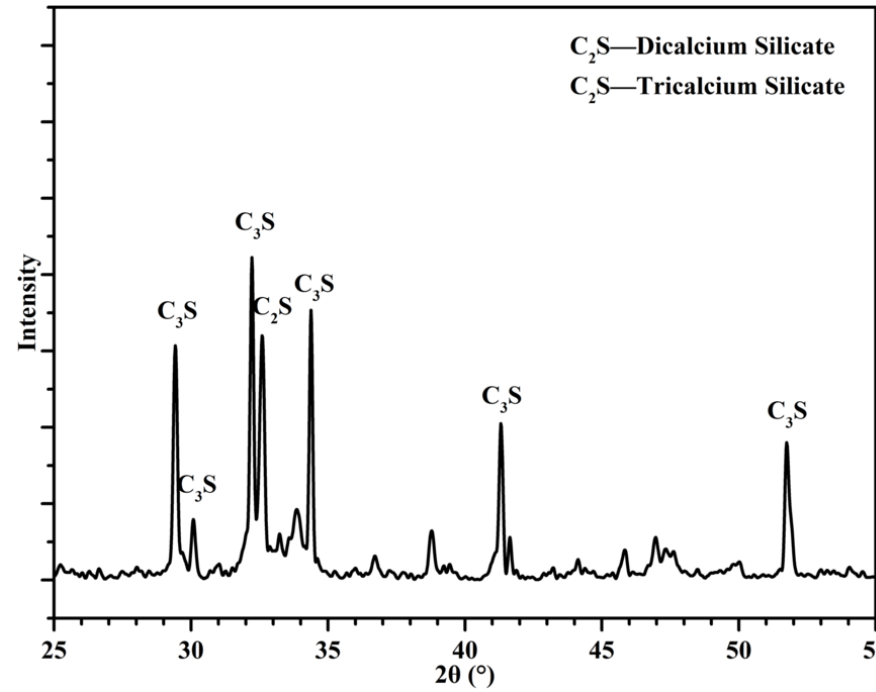
Figure 1. Mineral composition of cement.